Question: How would you classify this visualization?
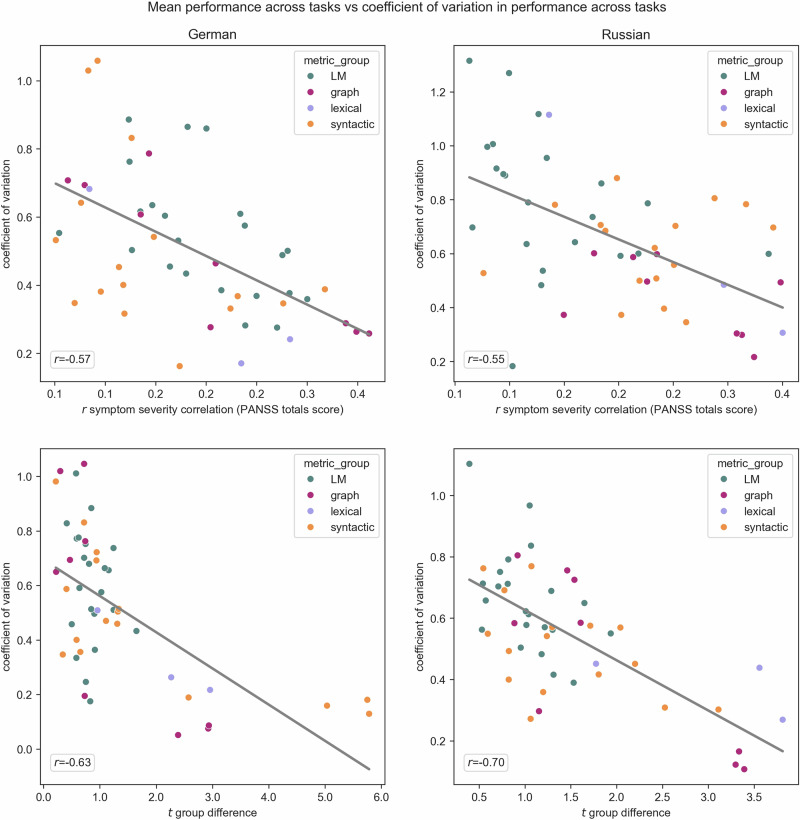
Answer: scatter